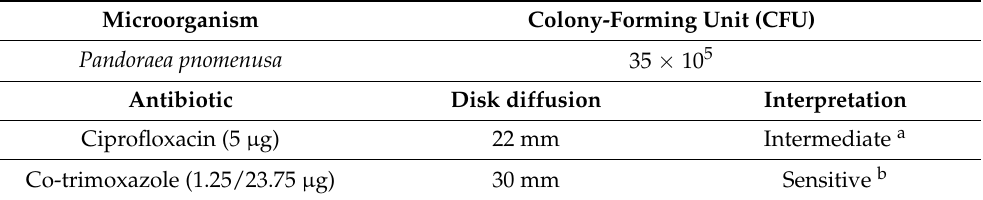
Figure 2. Chocolate agar with opaque white colonies of Gram ‐ negative bacilli consistent with P. pnomenusa. Table 2. Antibiogram and resistance profile of P. pnomenusa isolated from respiratory secretion.